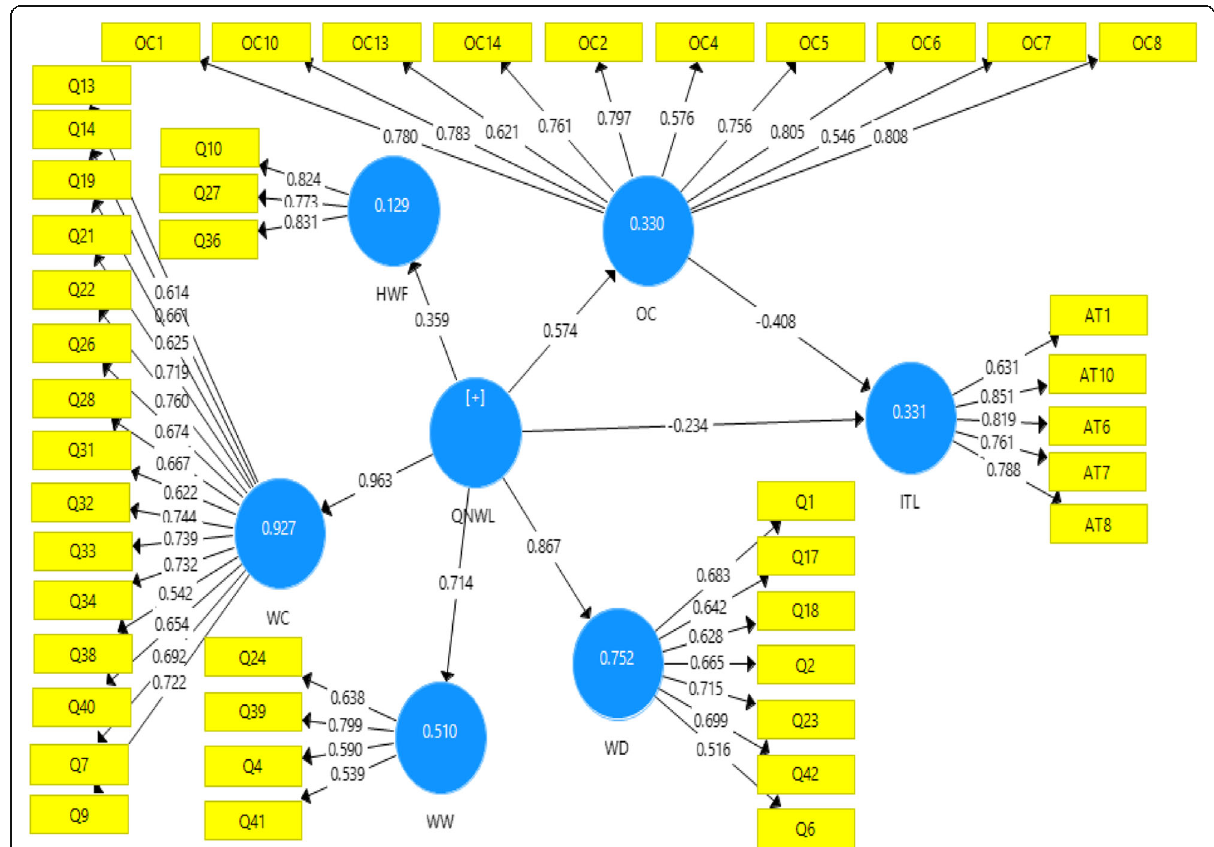
Fig. 2 Structural model with mediators